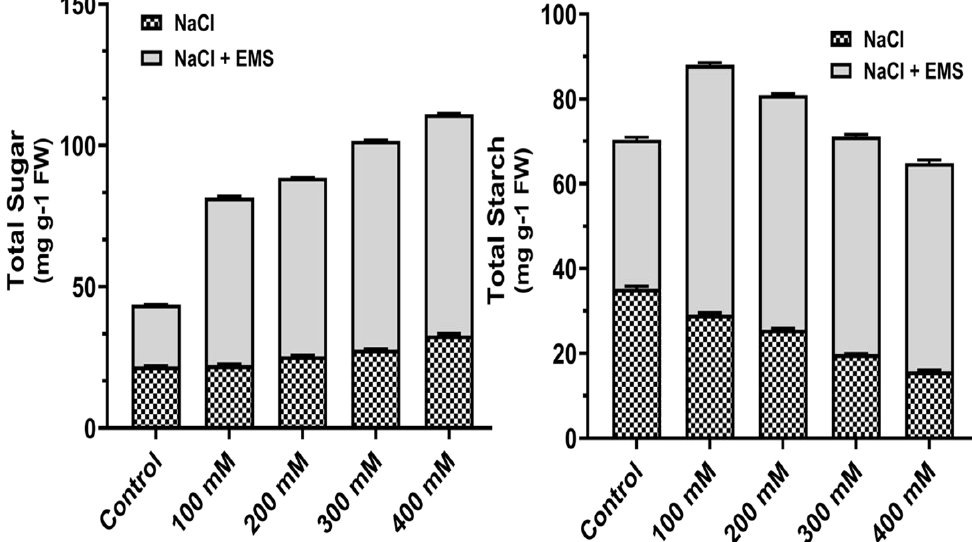
Figure 4. Mutagenic effect of sodium chloride (NaCl) and ethyl methane sulphonate (EMS) on carbohydrates (total sugar and starch) contents of callus of A. vulgaris . The values reflect the mean standard deviation of three independent experiments. According to DMRT, means separated by different letters are significantly different from each other at 5% level of significance ( p ≤ 0.05).